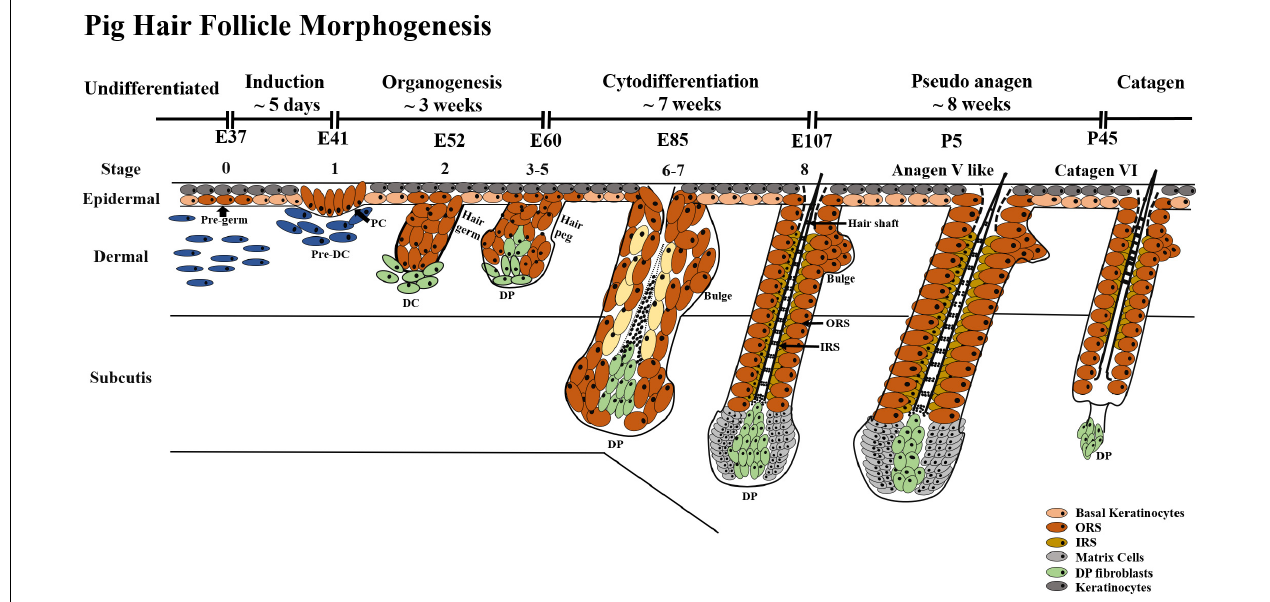
FIGURE 6 | HF morphogenesis development during pig embryogenesis. HF morphogenesis development in the prenatal stage is critically important, which determines HF cycle development in the postnatal stage. Pig HF morphogenesis development has been summarized into three main periods from E41 to P45 –